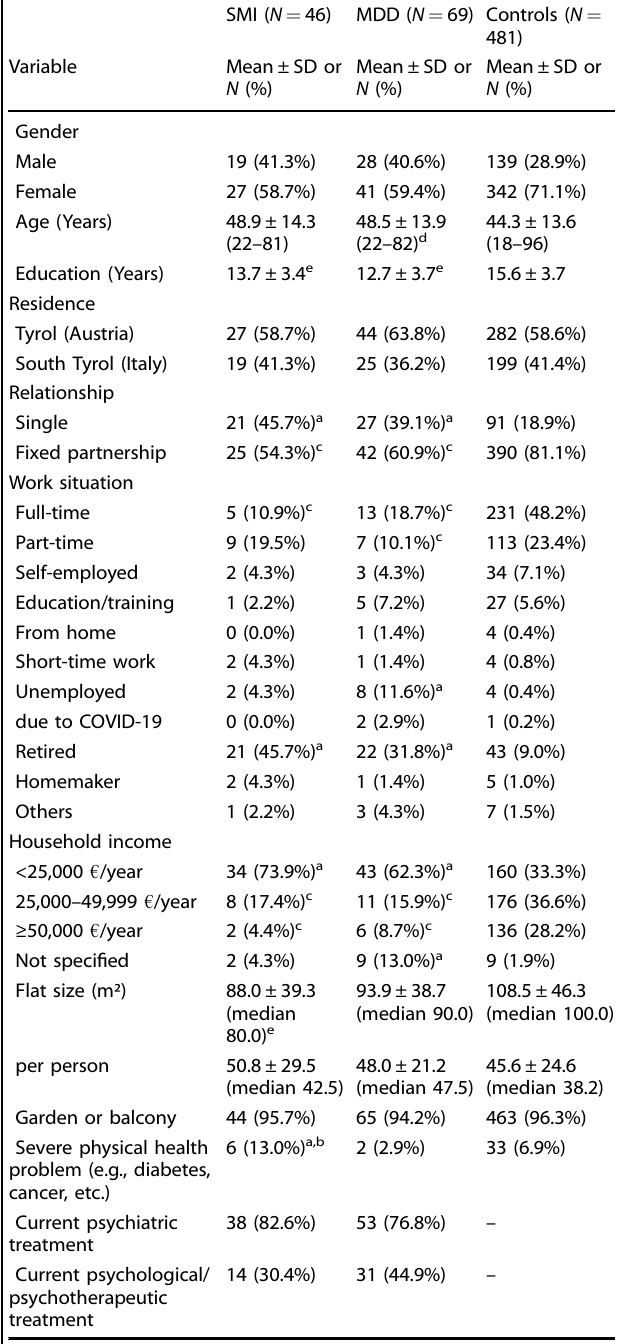
Table 1. Baseline